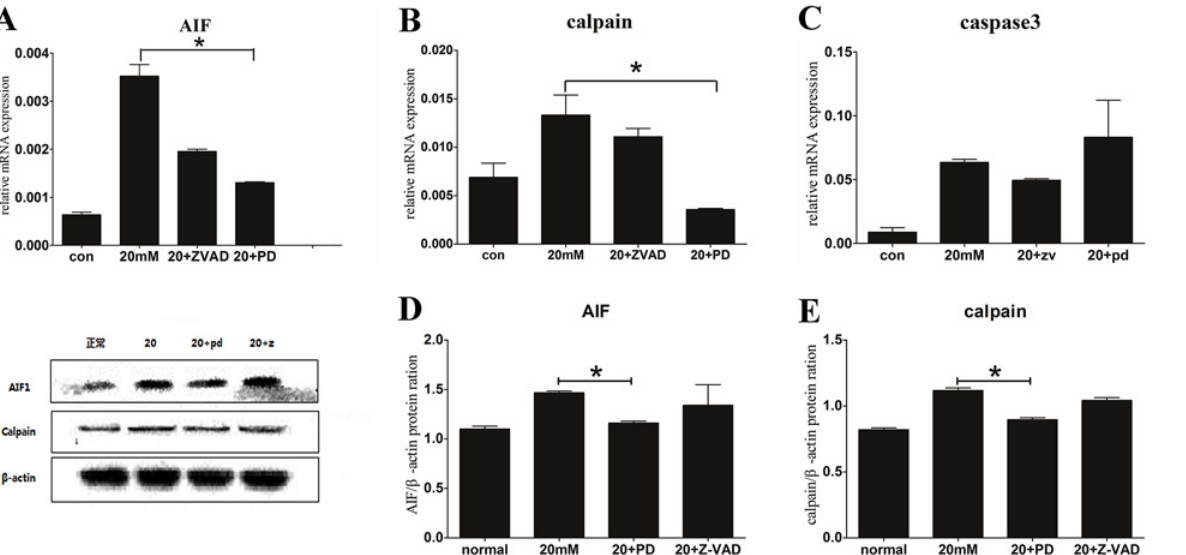
Fig 4. Relative expression of AIF and calpain in RT-PCR and WB. A, B, C show the SGN mRNA expression of AIF, calpain and caspase-3 in RT-PCR, respectively. The 20 mM Glu+PD150606-treated group showed a significant decrease compared with the 20 mM Glu-treated in AIF and calpain expression (P < 0.05); however, there was no significant difference in caspase-3 expression (P > 0.05). The three photos below show the western blot results of the cultured SGNs. D, E represent the protein ration of AIF and calpain in all groups, respectively. The 20 mM Glu+PD150606-treated group had a minimal decrease compared with the 20 mM Glu-treated group for both AIF and calpain expression, which was consistent with the RT-PCR results.